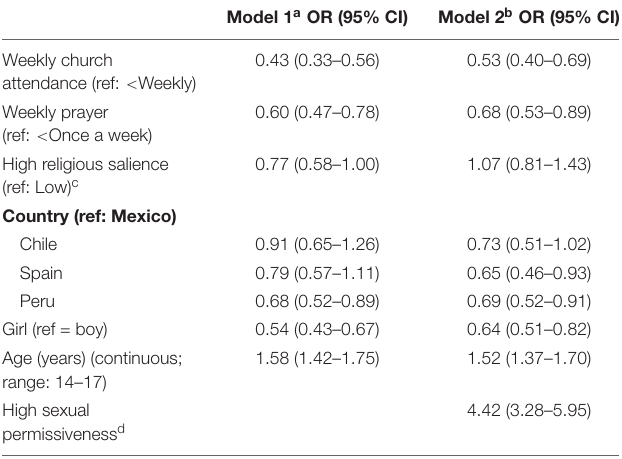
TABLE 3 | Association between religious dimensions and sexual